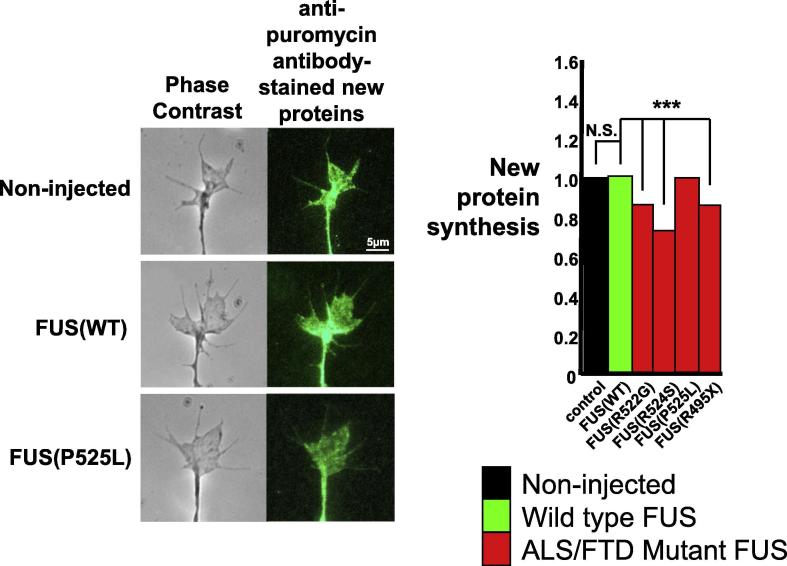
Pathological fALS-FUS mutant FUS condensates have impaired function. By sequestering the machinery of RNA metabolism and translation, the mutant fibrillar condensates cause significant reductions FUS RNP granule function, as measured by reductions in new protein synthesis in axon terminals. New proteins are identified by an assay in which puromycin incorporated into new proteins can be detected using an anti-puromycin antibody. Adapted from Murakami et al., neuron 88: 678, 2015.